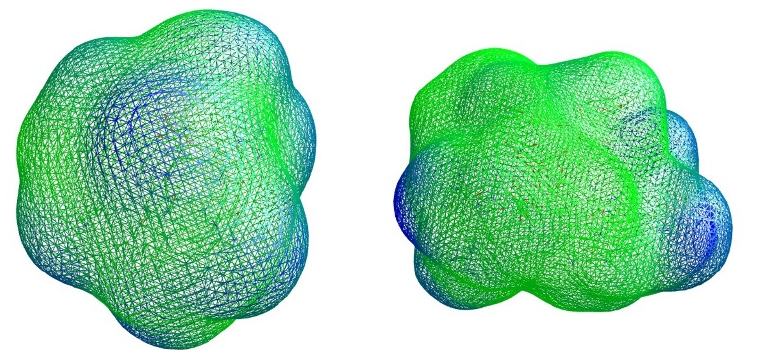
Figure 6. Dashed molecular lipophilicity potential (MLP) maps obtained for a complex formed by three molecules of norfloxacin and one of peptide 6 ( left ) and a complex formed by three molecules of novobiocin and two of peptide 6 ( right ). Hydrophobic regions are colored in green and hydrophilic regions in blue.